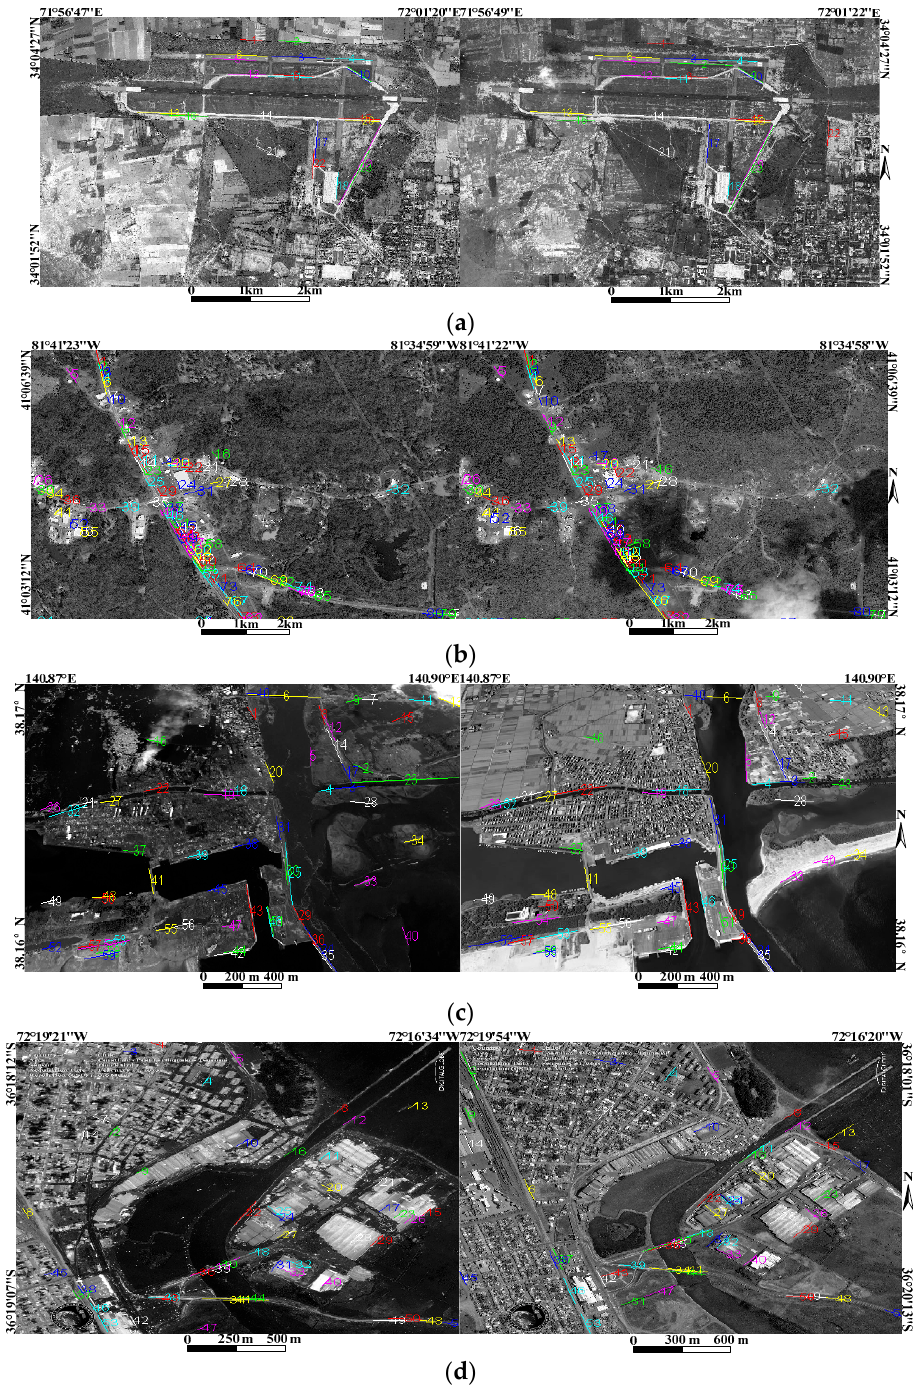
Figure 13. Matching results of the RMLSL on the high-resolution real image pairs. ( a ) The first image pair in the second group: QuickBird-WorldView; ( b ) the second image pair in the second group: QuickBird-QuickBird; ( c ) the third image pair in the second group: QuickBird-QuickBird; ( d ) the fourth image pair in the second group: QuickBird-QuickBird.